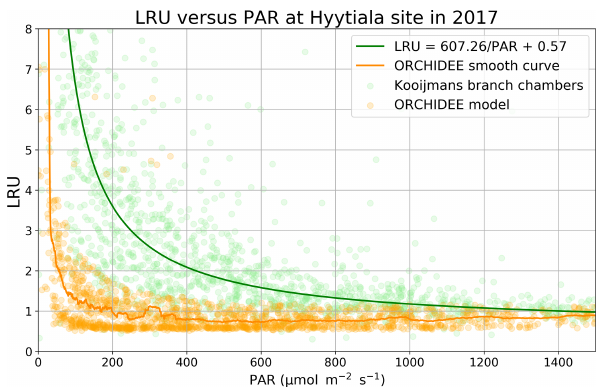
Figure 4. LRU against PAR (Hyytiälä) for ORCHIDEE outputs and measurements (hourly data measured between 18 May and 13 July; Kooijmans et al., 2019). The light green circles represent average LRU values for chambers 1 and 2, and light orange circles repre- sent modelled LRU values. A moving average with a window of 50 points leads to the smooth orange curve for the model. The green line represents the function LRU = 607.26/PAR + 0.57 from Fig. S6 of the Kooijmans et al. (2019) supplement. To focus on LRU be- haviour when PAR decreases, we plotted LRU response to PAR for PAR < 1500µmolm − 2 s − 1